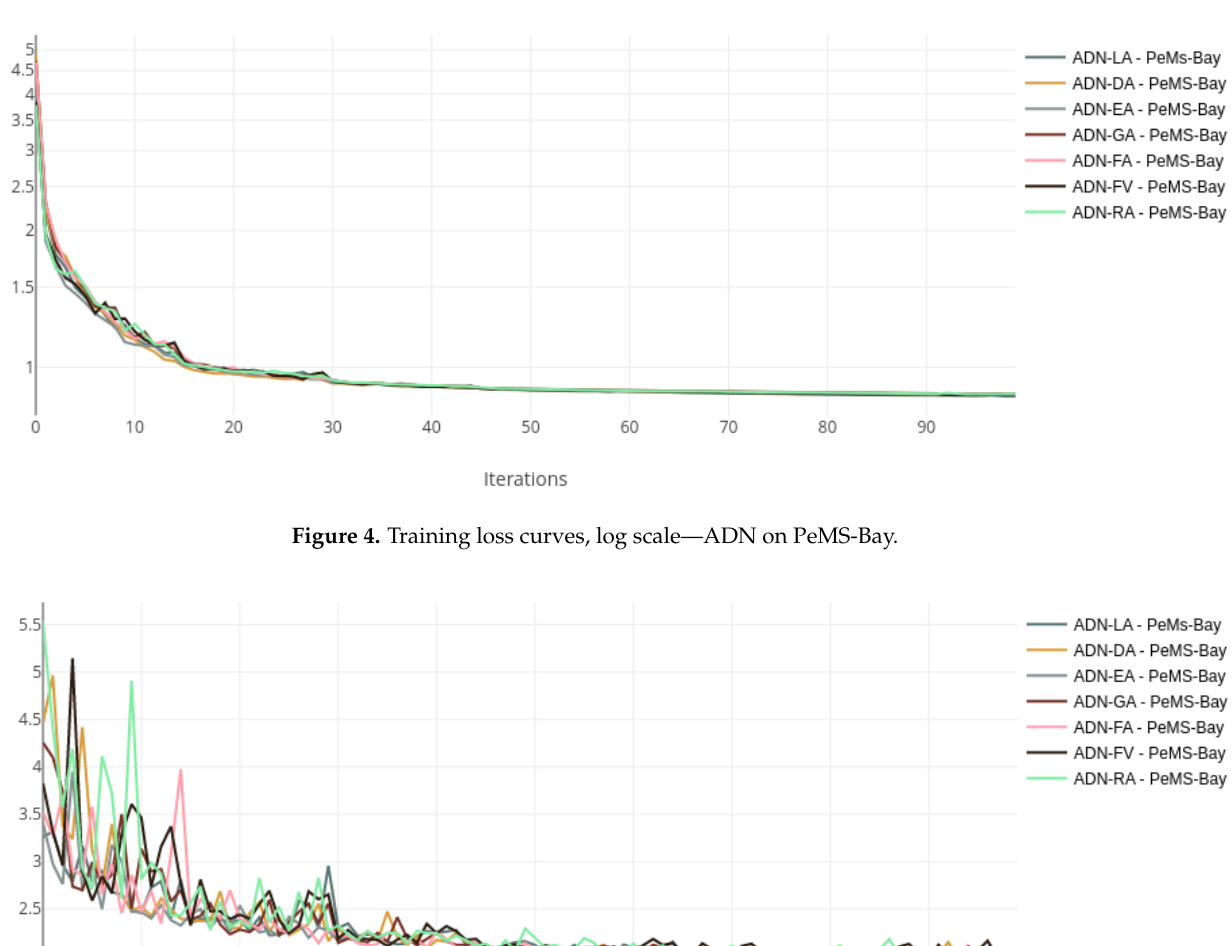
Figure 3. Validation loss curves—ADN on Metr-LA.